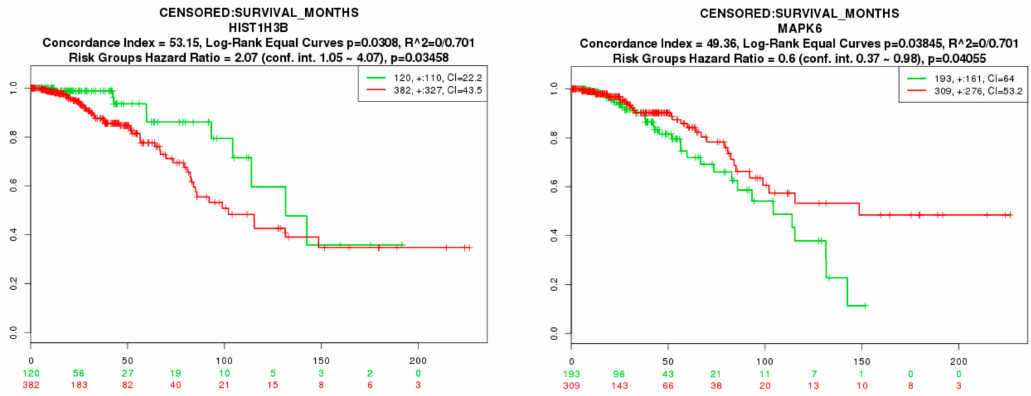
Figure 17. Kaplan-Meier survival curves using The Cancer Genome Atlas (TCGA) data validate the prognostic value of genes having favorable overall survival in BRCA (Green—low expression; Red—high expression).